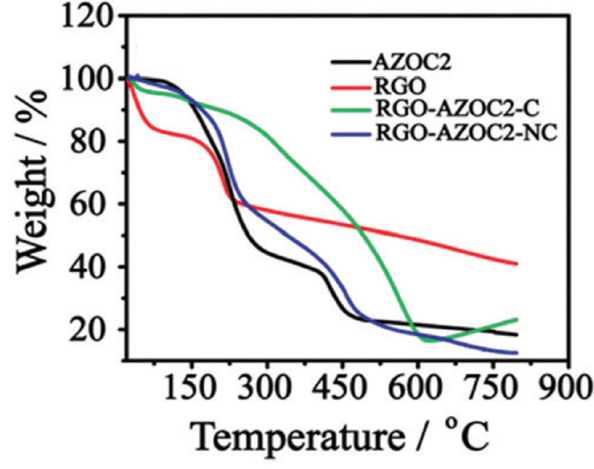
Figure 22. TGA curves of AZO moiety, RGO, RGO-AZOC2-C and RGO-AZOC2-NC hybrids. (Reprinted from [116]; published by The Royal Society of Chemistry).